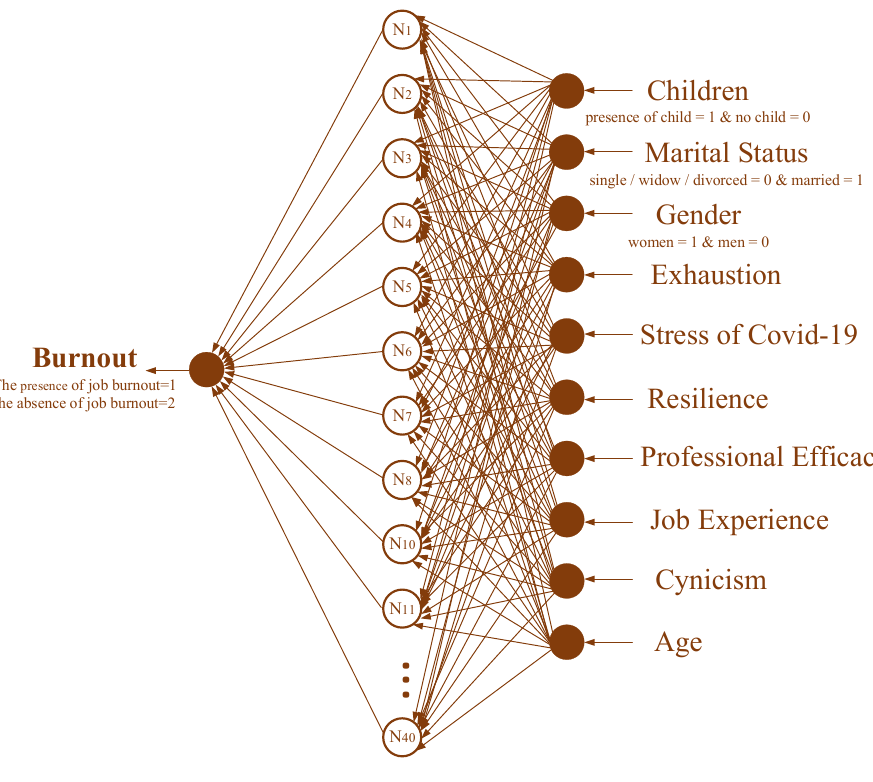
Figure 1. The structure of the trained RBF neural network. Table 2. Specifications of designed networks.